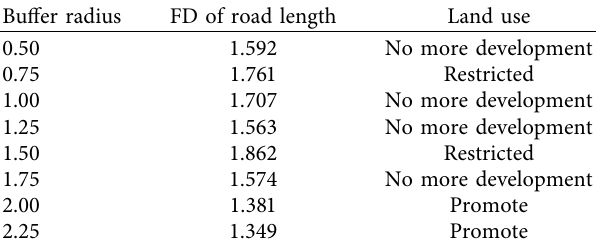
Table 5: Relationship between bufer interval and land use. Bufer radius